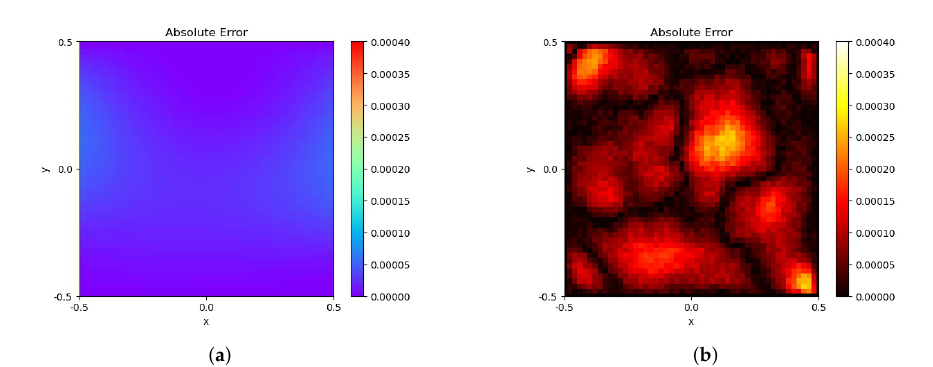
Figure 7. The absolute error between the PINN result and the FEM results: ( a ) the electric potential (V); ( b ) the temperature